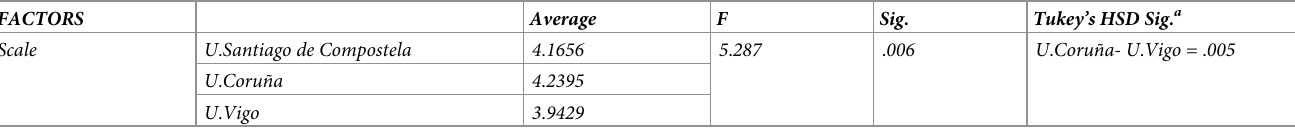
Table 5. Result of student’s t-test for the contrast of independent averages. FACTORS